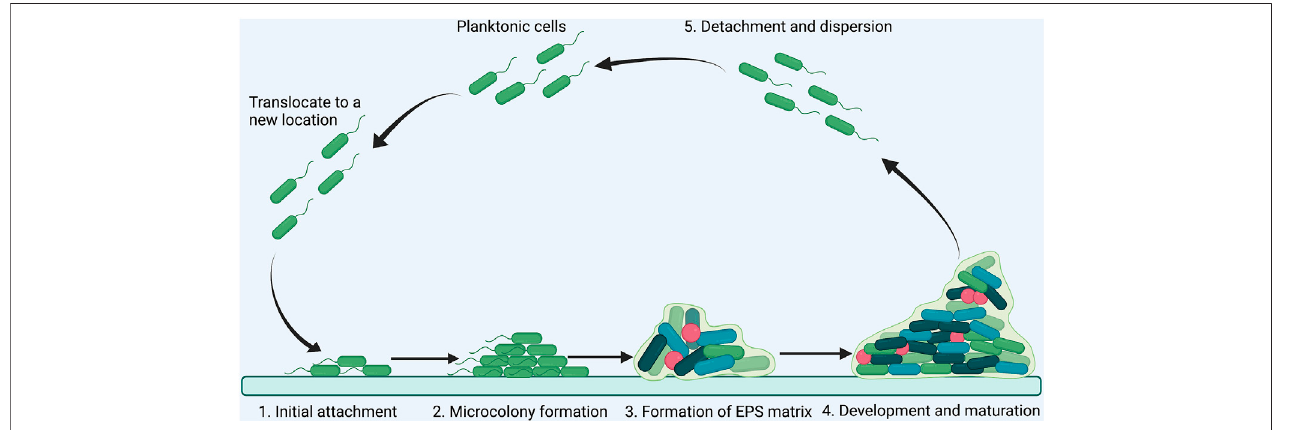
FIGURE3| Schematicillustrationofthestepsinvolvedin P.aeruginosa bio fi lmformation.Theformationof P.aeruginosa bio fi lmhas fi vesteps: (A) initialattachment of planktonic bacteria to a surface; (B) microcolony formation; (C) formation of EPS matrix; (D) development and maturation; (E) detachment and dispersion.